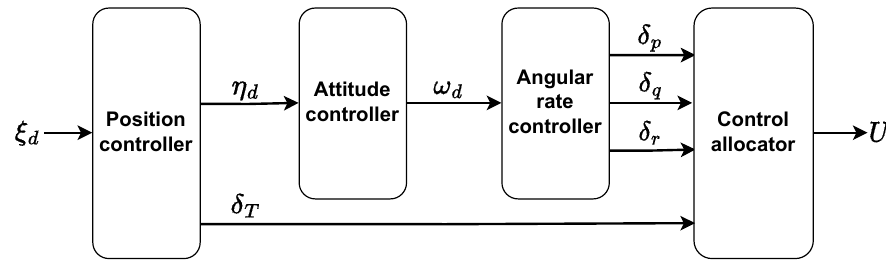
Figure 6. Control architecture employed in widely used autopilots such as PX4 or Arducopter. For the operation of a multirotor UAV at a constant altitude, the thrust control signal is of a magnitude to provide the force required to compensate for the weight of the multirotor UAV, for which there is a control signal for each of the rotors. The angular velocity control signals will generate variations in the control signals of each rotor around the point required to generate the thrust force. The force generated by each rotor f r is calculated